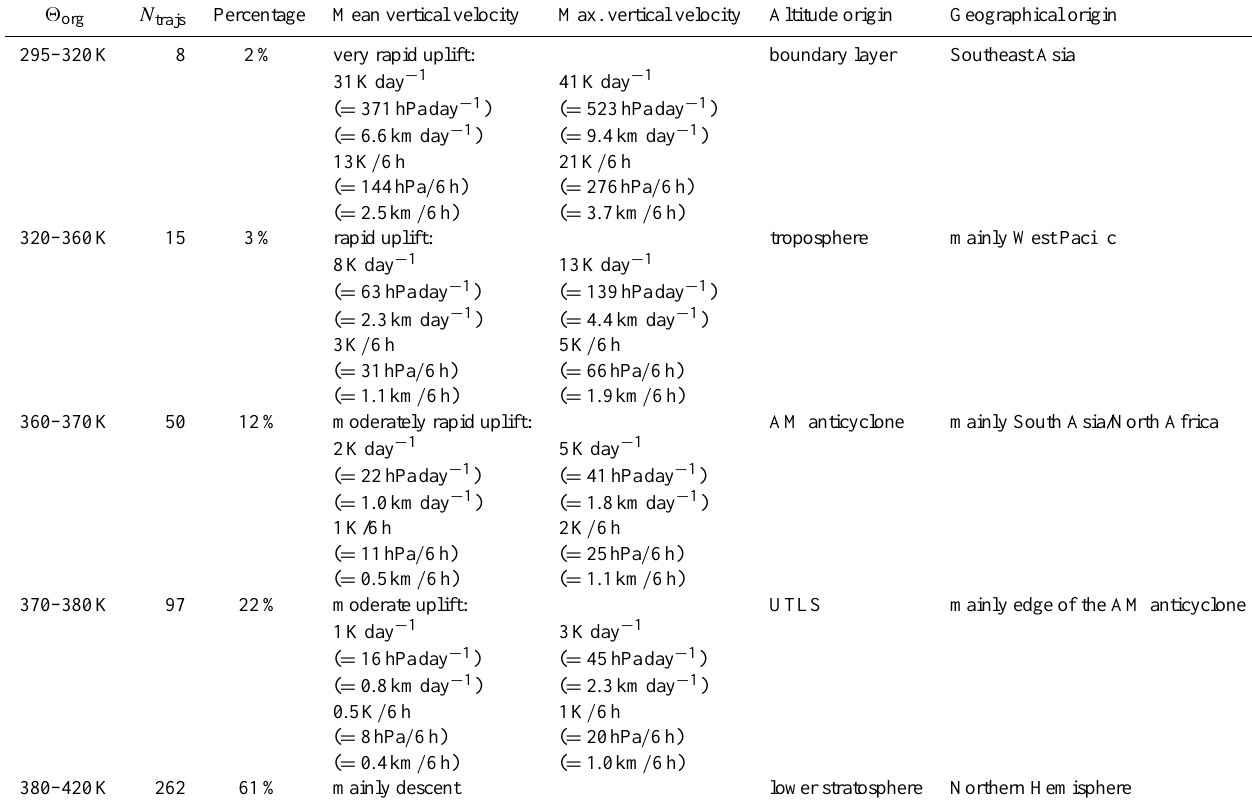
Table 1. Number ( N trajs ) and percentage of all trajectories in the region of interest (in total 432 trajectories), mean and maximum vertical velocity (calculated between 17 and 27 August 2012) along 40-day backward trajectories depending on levels of potential temperature at the air mass origin ( (cid:50) org ). The 40-day backward trajectories start at the observation on 26 September 2012 and end at the origin of the air masses in the past (17 August 2012). The air mass origins in terms of altitude and geographical position are also